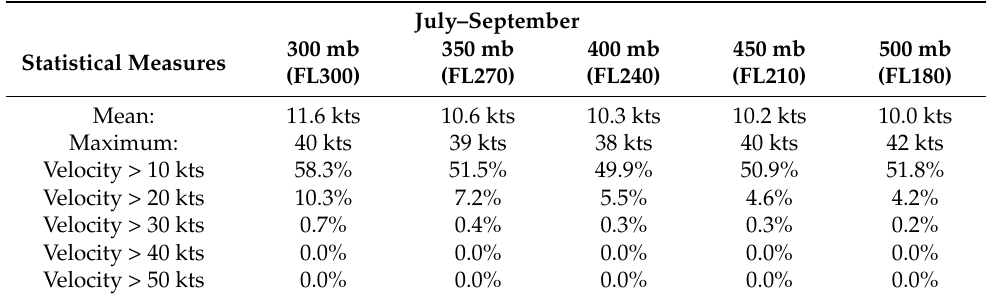
Table 5. Data of the mean, maximum and accumulated frequency of wind speed at levels from 500